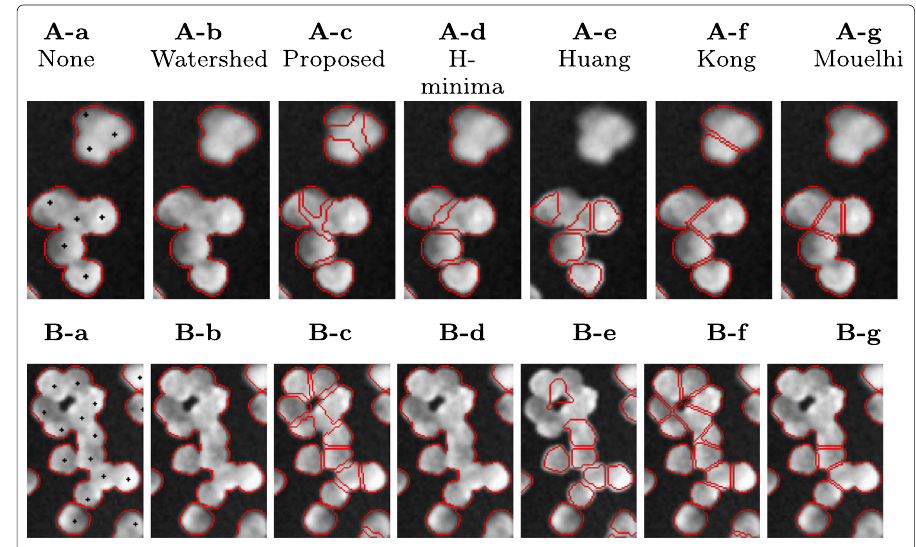
Fig. 5 Cluster splitting results comparison. Images in the top row A shows two clusters. The top 1 is an example of class III—objects are heavily packed with high overlap. The lower one in top row is from class II—it is more typical situation, with multiple objects touching and overlapped. In the bottom row B , the cluster is from class IV—numerous objects with various